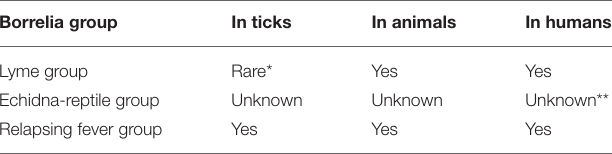
TABLE 1 | Vertical transmission of borreliae. Borrelia